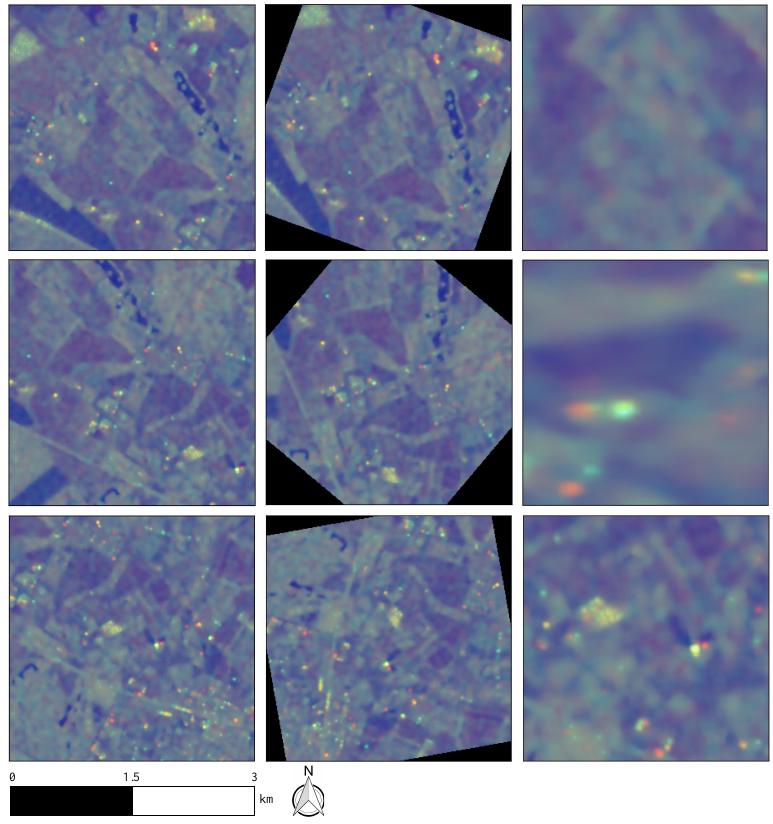
Figure 5. Visualization of augmented images using rotating and